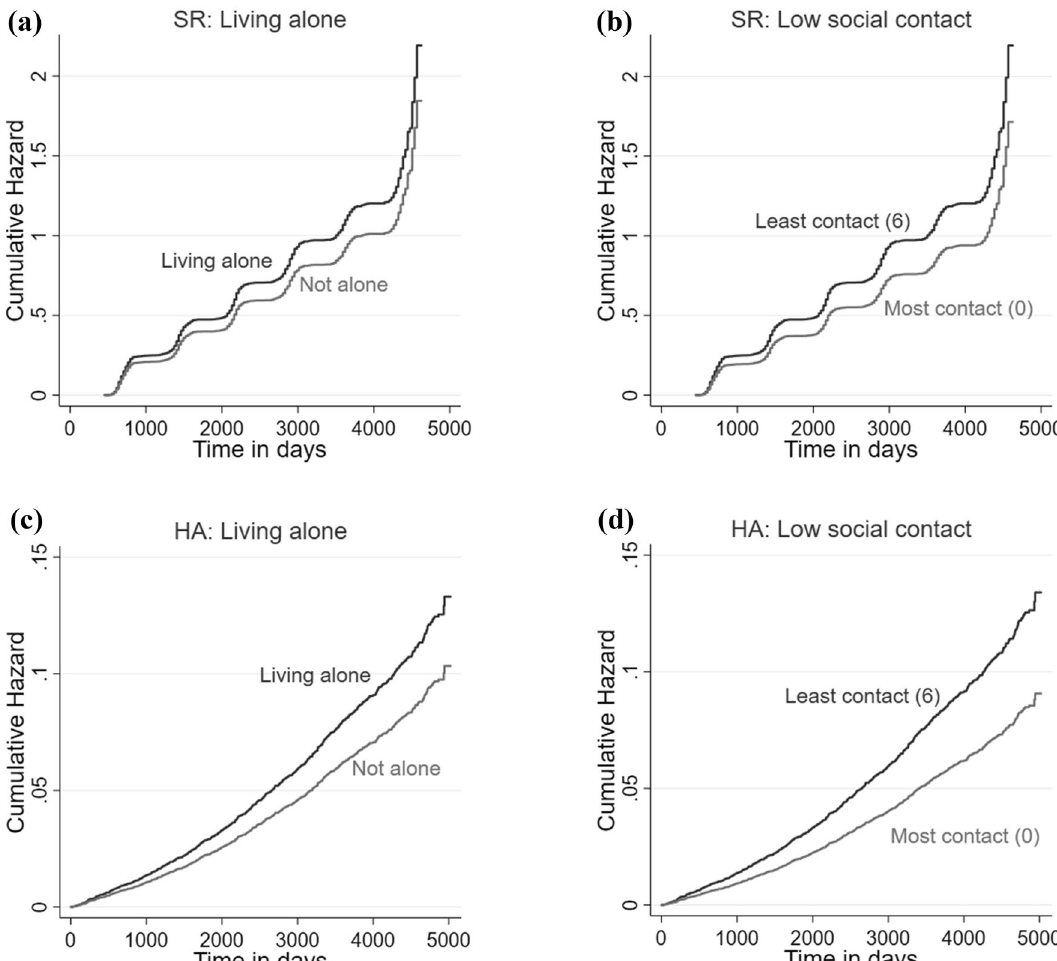
Figure 2. Estimated cumulative hazards by social isolation measures for the self-reported (SR) cohort and the hospital admission (HA)